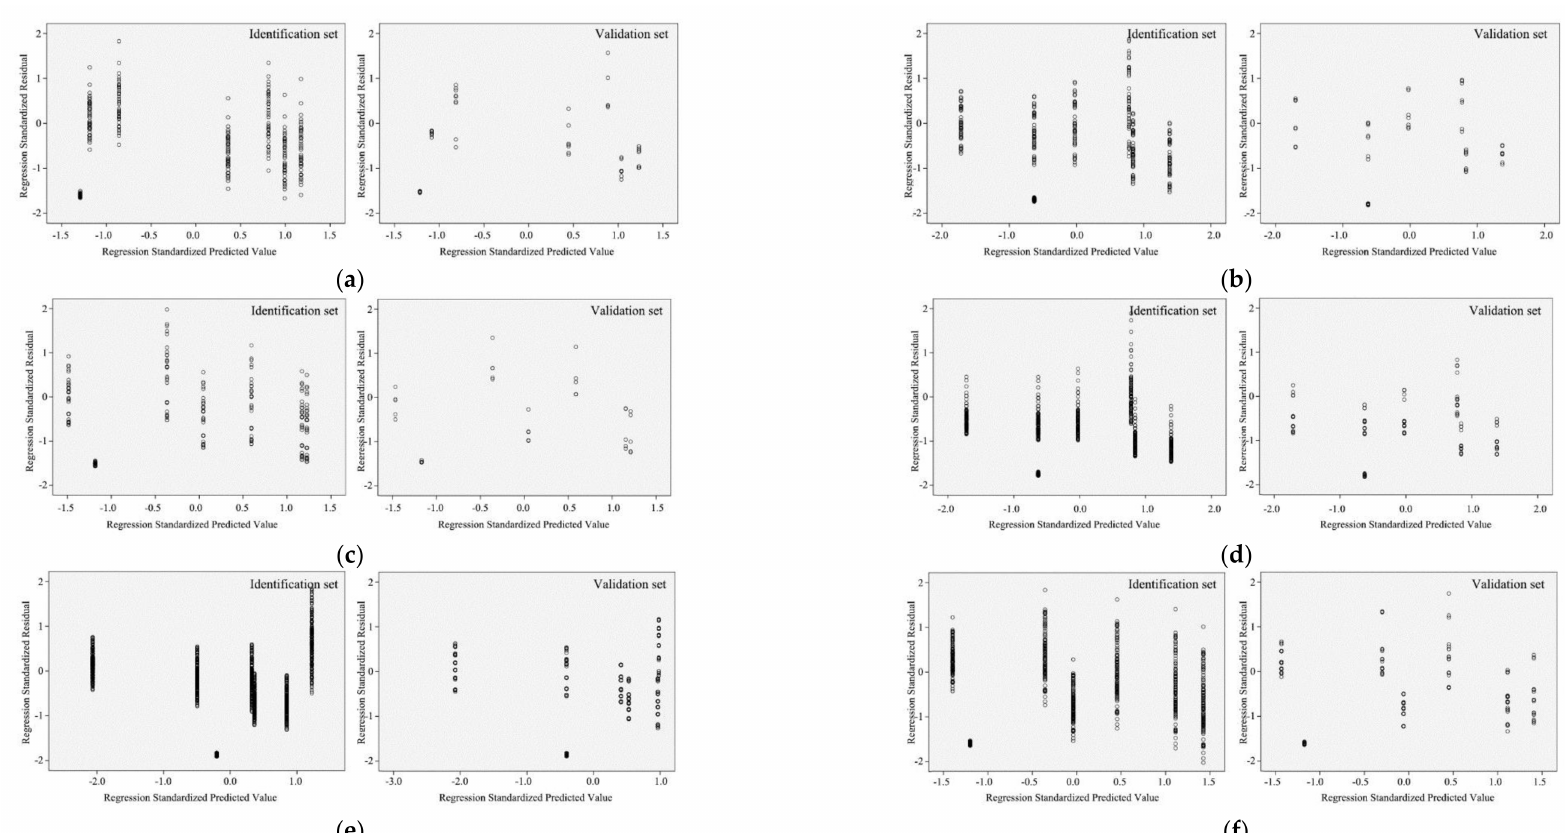
Figure 7. Regression standardized residual for climate models: ( a ) hotel; ( b ) retail building; ( c ) hospital; ( d ) educational building; ( e ) residential building; ( f ) o ffi